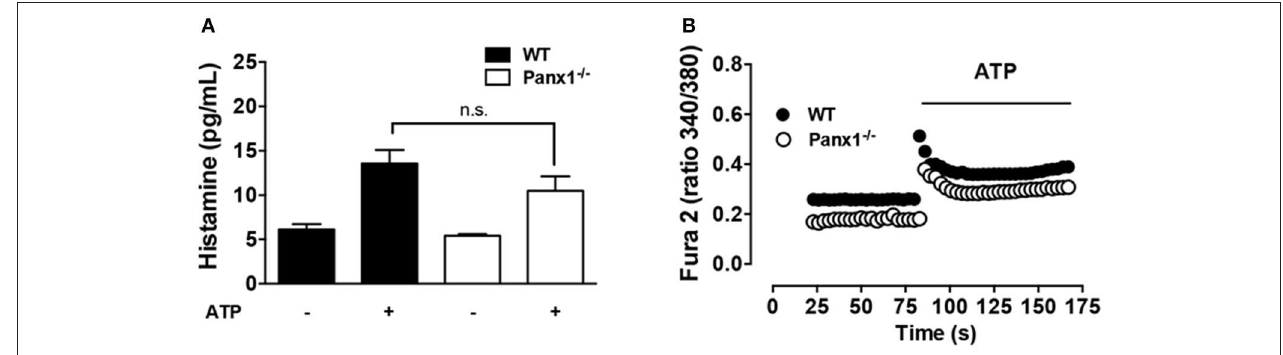
FIGURE 4 | The degranulation and Ca 2 + signal response of Panx1 − / − mast cells are bypassed by exogenous ATP. (A) Extracellular histamine concentration in IgE-sensitized WT (black) and Panx1 − / − mast cells (MCs) (white) under basal conditions and after 20min stimulation with 500 µ M ATP. (B) Intracellular Ca 2 + signal evaluated with Fura-2 in WT (black) and Panx1 − / − (white) MCs. Each value corresponds to the mean ± SEM, n = 5; between 30 and 50 cells were recorded in each experiment, no significance (n.s.) p > 0.05.